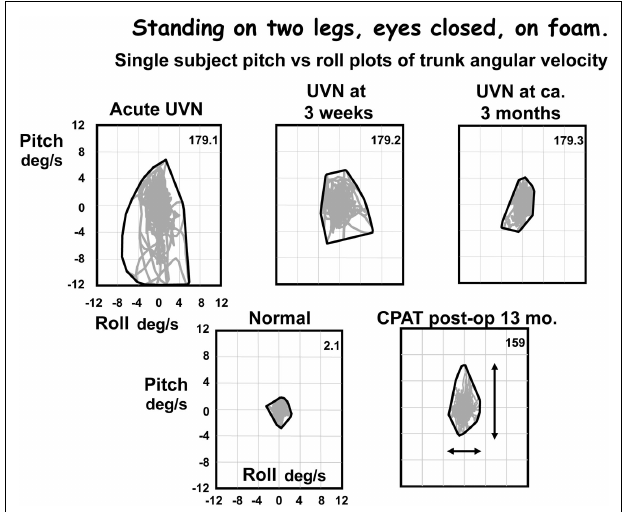
FIGURE 3 | Pitch versus roll plots of lower trunk (L1-3) angular velocity. The x – y plots were formed based on the pitch and roll velocities of the traces in Figure 2 . Note that although the angle excursions look similar in all traces except the upper traces in Figure 2 , the angular velocities are very different.Velocities for the CPAT patient at 13months post-operatively are similar to those of the UVN patient at 3months after acute onset.The peak to peak measures used to compare population responses in Figures 4 – 6 are indicated by the arrows on the CPAT x – y plot. An envelope has been drawn around the x –y traces, that is the convex hull.